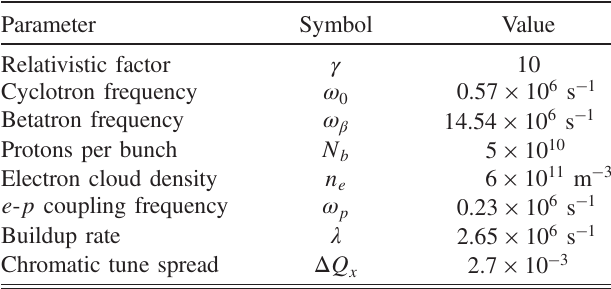
TABLE II. Parameters of the model.